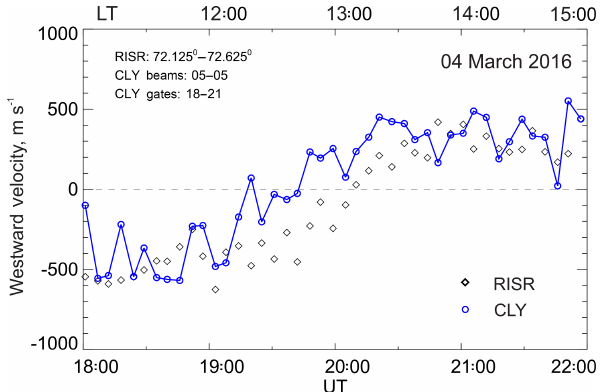
Figure 5. Eastward component of the E × B drift as measured by RISR (diamonds, 5min resolution data) and matched velocity me- dians of CLY observations (blue circles, 5min medians of original 1min measurements in beams and gates overlapping the region of RISR observations) for the event of 4 March 2016. For the area of observations, local time (scale at the top) roughly coincides with the magnetic local